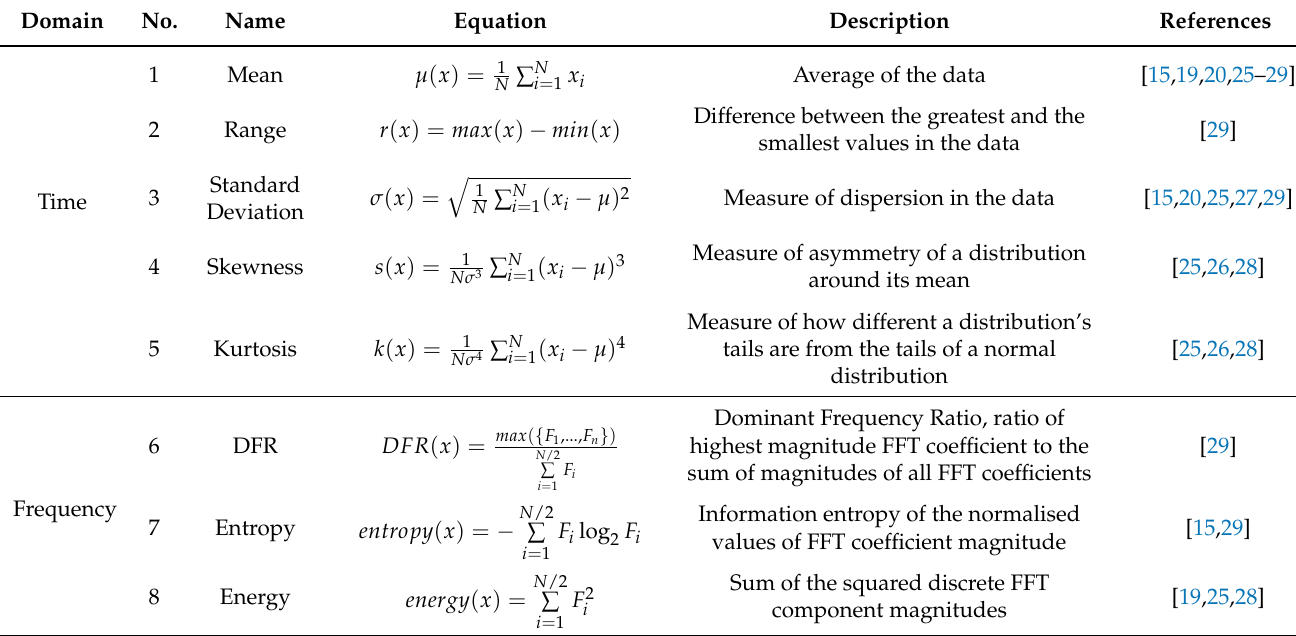
Table 1. Summary of features extracted from data series generated by each sensor ( x ) per each window of size N . The frequency-domain features were calculated using the Fourier Transform coefficients ( F i